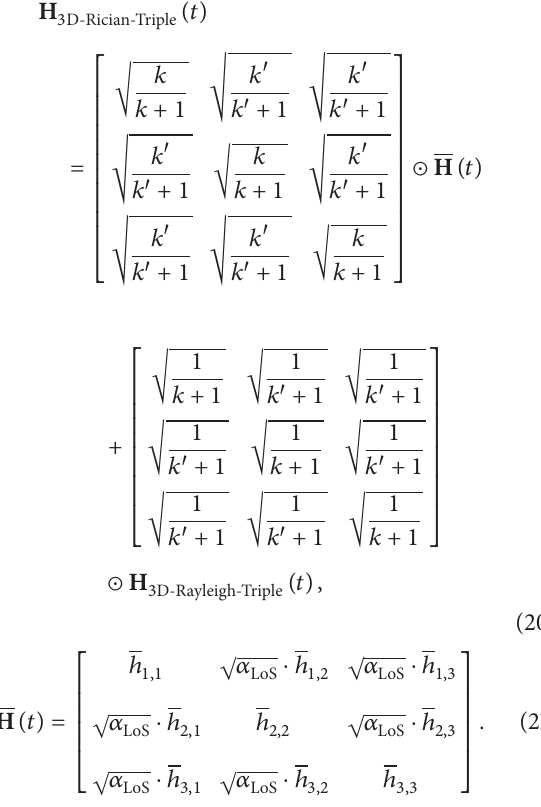
nel Model. Figure 3 shows the normalized fading envelopes of the co-/cross-channel links in the PS 3D triple-polarized Rayleigh channel model, assuming that all of the generated channel links are independent. The solid 𝐻 11 line represents the fading envelope of the cochannel link; the 𝐻 12 and 𝐻 13 dotted lines depict the envelopes of the cross-channel links. The mean value of the fading envelope for cochannel 𝐻 11 is almost 5.8 dB higher than those found for cross-channels 𝐻 𝐻 12 and 13 due to the NLoS XPD value shown in Table 3. Figure 3(a) shows the MS mobility at 0 km/h, wherein the channel envelopes do not change during one-packet duration (100 symbols). Figure 3(b) shows the MS mobility at 60 km/h; the channel envelopes are continuously time-varying due to the MS